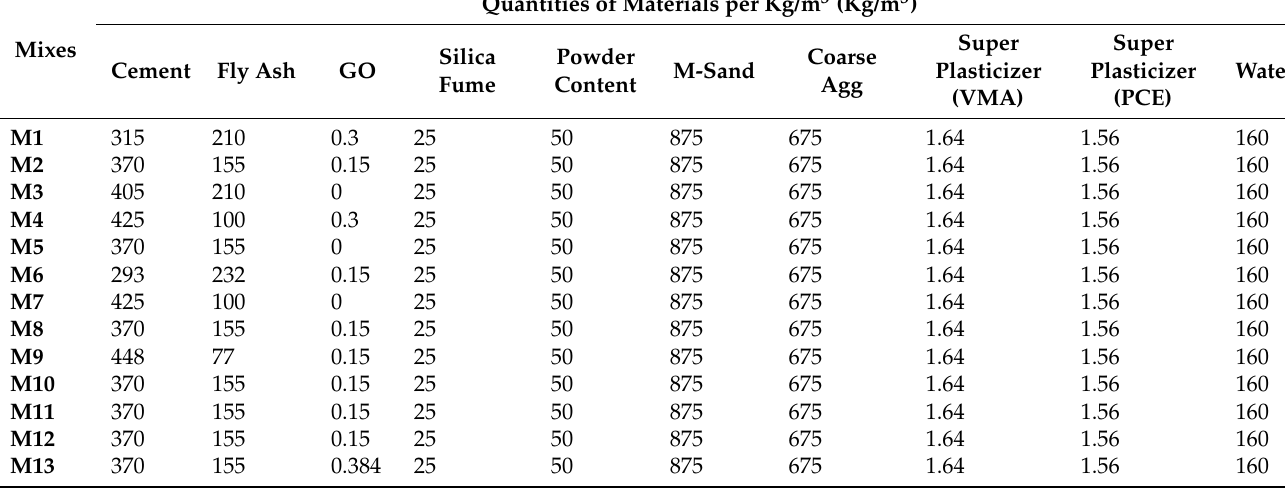
Table 6. Constituent materials for each